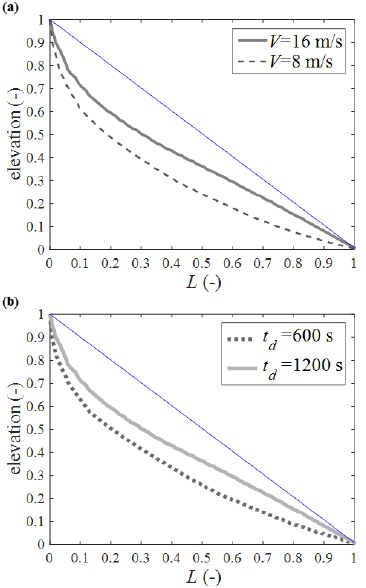
Figure 9. Channel profiles after 5Ma from simulations with (a) dif- ferent V ( t d = 1200s) and (b) different t d ( V = 16ms − 1 ). The pro- file of the main channel of the largest catchment in each simulation is shown. For comparison, profiles are normalized with maximum elevation and lengths. Blue straight line is drawn to help visually identify the profile